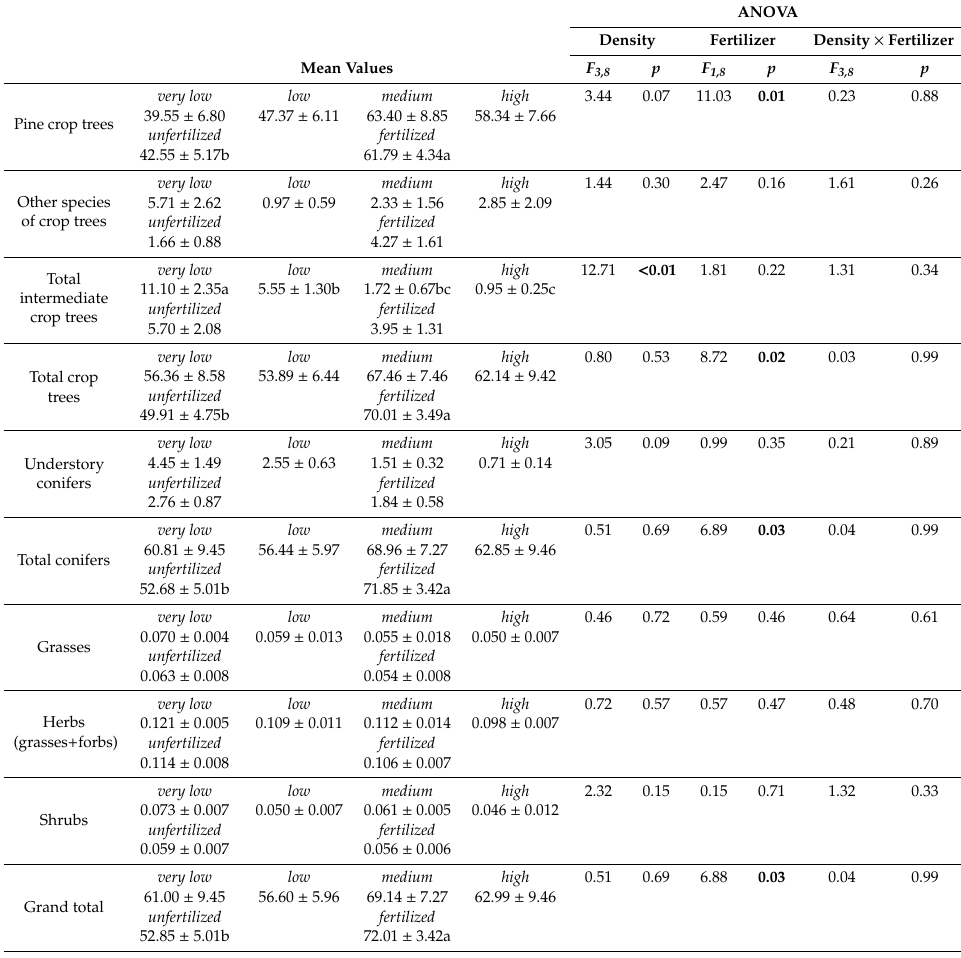
Figure 7. Mean ( n = 2, 3 replicate study areas; ± SE) total carbon storage (Mg / ha) of total crop trees and intermediate (ingress) crop trees in the very low-, low-, medium-, and high-density stands of lodgepole pine with (F) and without (UF) fertilization, and in unthinned (Unthin) and old-growth (Old G) stands, 25 years after initiation of treatments. Table 5. Mean ( n = 2 replicate study areas) ± SE 25-year responses (1993 to 2018) of above- and below- ground carbon storage (Mg/ha) for young lodgepole pine stands among four post-thinning densities (PCT) and two fertilization (FERT) treatments. Results of analysis of variance (ANOVA) are provided. Within a row, mean values with different letters are significantly different by Duncan’s multiple range test. Significant values in bold.